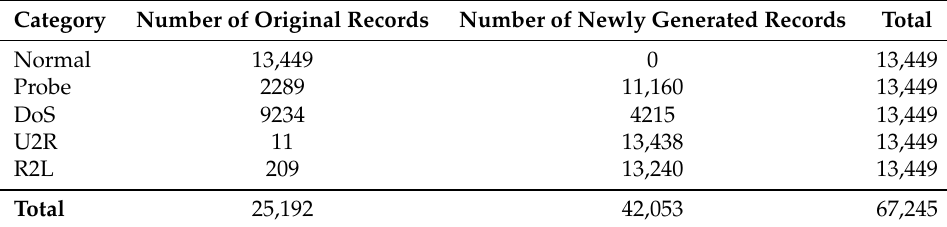
Table 4. Number of samples generated on the NSL-KDD training dataset.